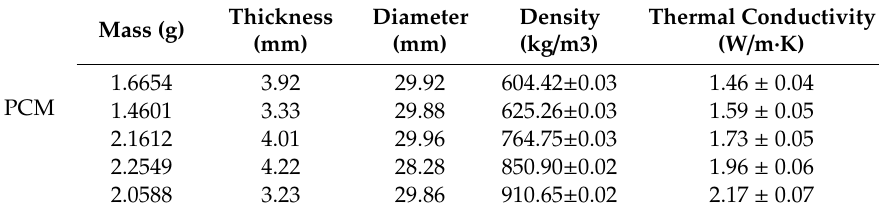
Table 3. Parameters of CA–MA/EG with different packing densities.